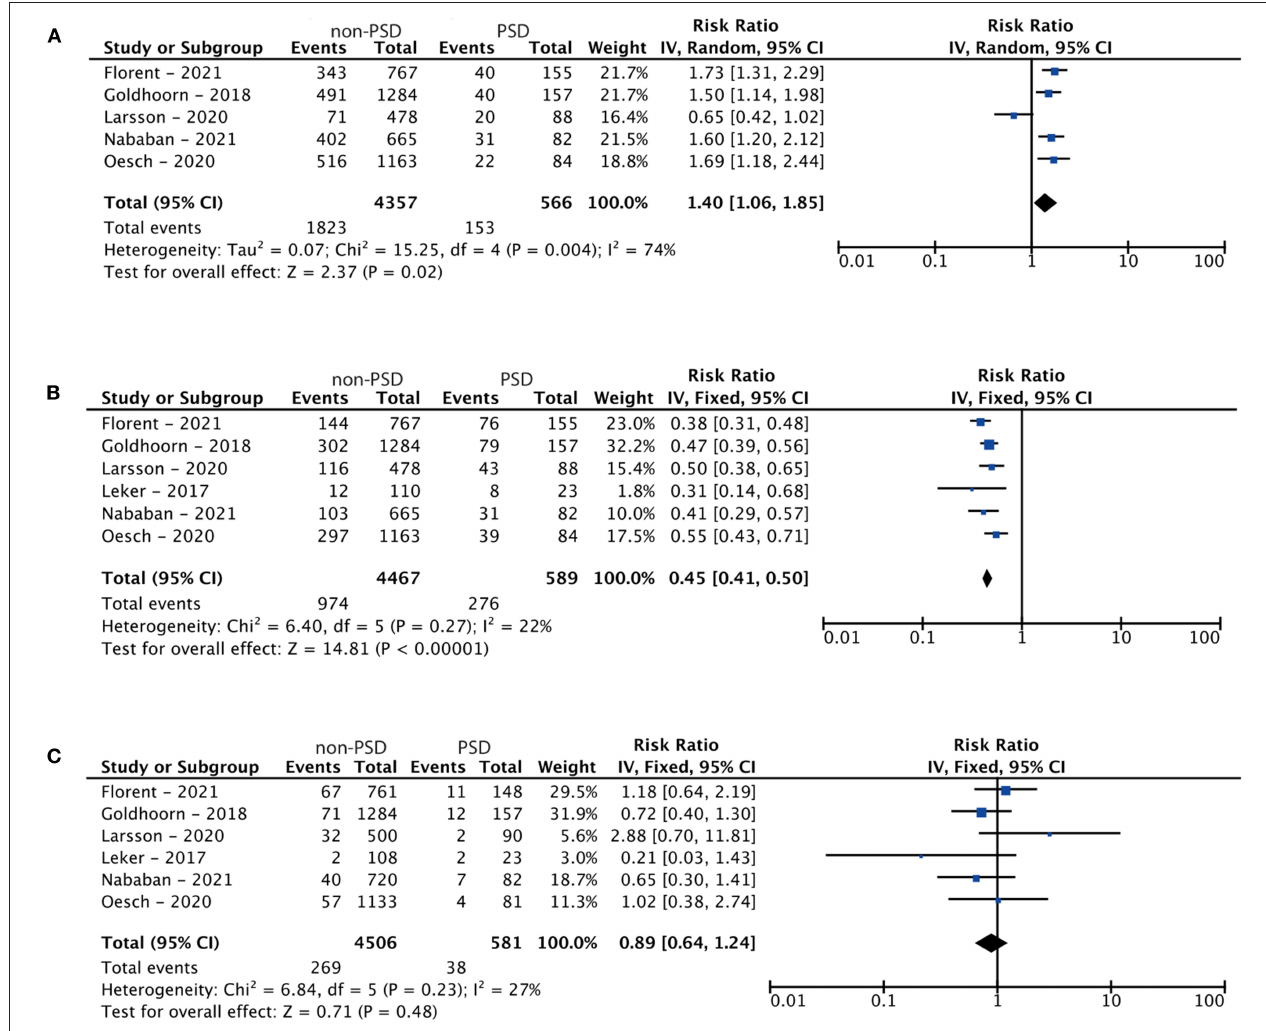
FIGURE 3 | Forest plots: (A) meta-analysis of the clinical outcome of endovascular thrombectomy in patients with pre-stroke dependency at 90 days, (B) meta-analysis of mortality in patients with pre-stroke dependency undergoing endovascular thrombectomy, and (C) meta-analysis of the rate of symptomatic intracranial hemorrhage related to